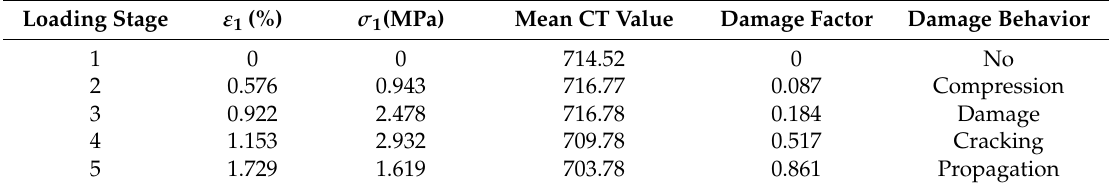
Table 3. Stress, strain, and mean of the CT value and the damage factor of the CWRB sample. Loading Stage